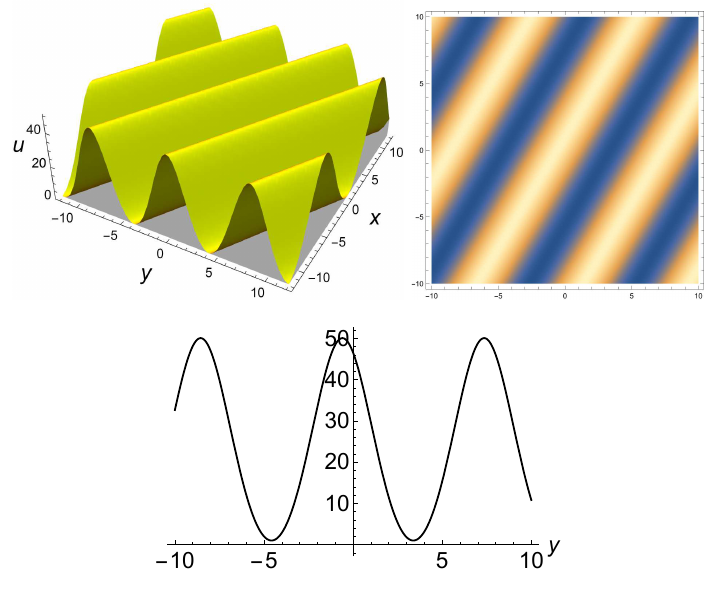
Figure 3. The 3D and 2D solution profiles of (29).